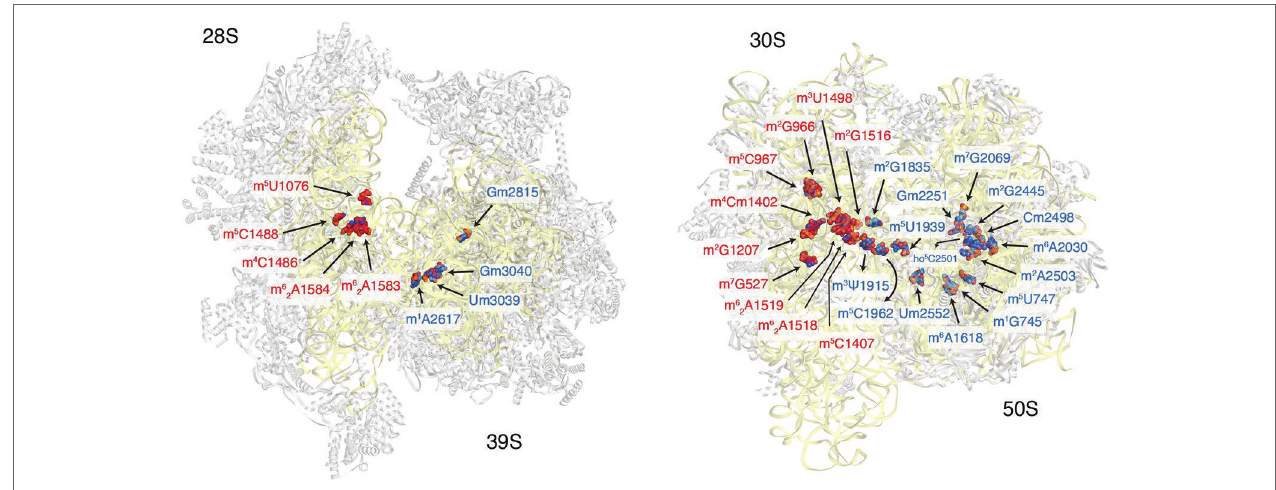
FIGURE 1 | Distribution of ribosomal RNA (rRNA) methylation sites on human mitoribosome and bacterial ribosomes. The location of rRNA-methylation sites on ribosomal small subunit (red) and large subunit (blue) are displayed on the structure of human mitoribosome ( left , PDB: 3J9M) and Escherichia coli ( right , PBD: 4YBB). The ribosomal proteins are colored gray and the rRNA is in yellow.